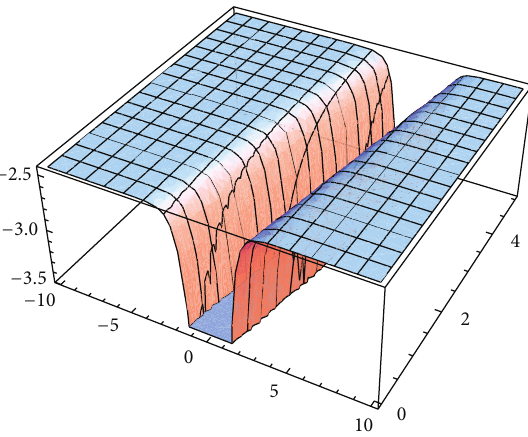
Figure 6: Travelling waves solutions (48) are plotted: dark solitary